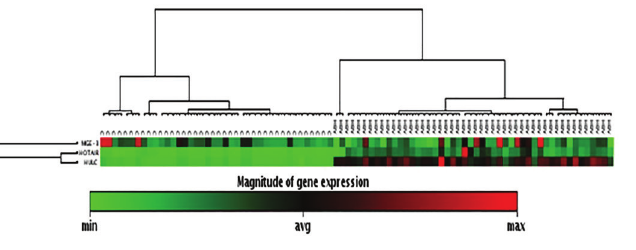
Figure 2 - Magnitude of gene expression